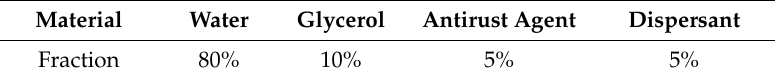
Table 2. Fractions of di ff erent components in finishing solution [16,17].